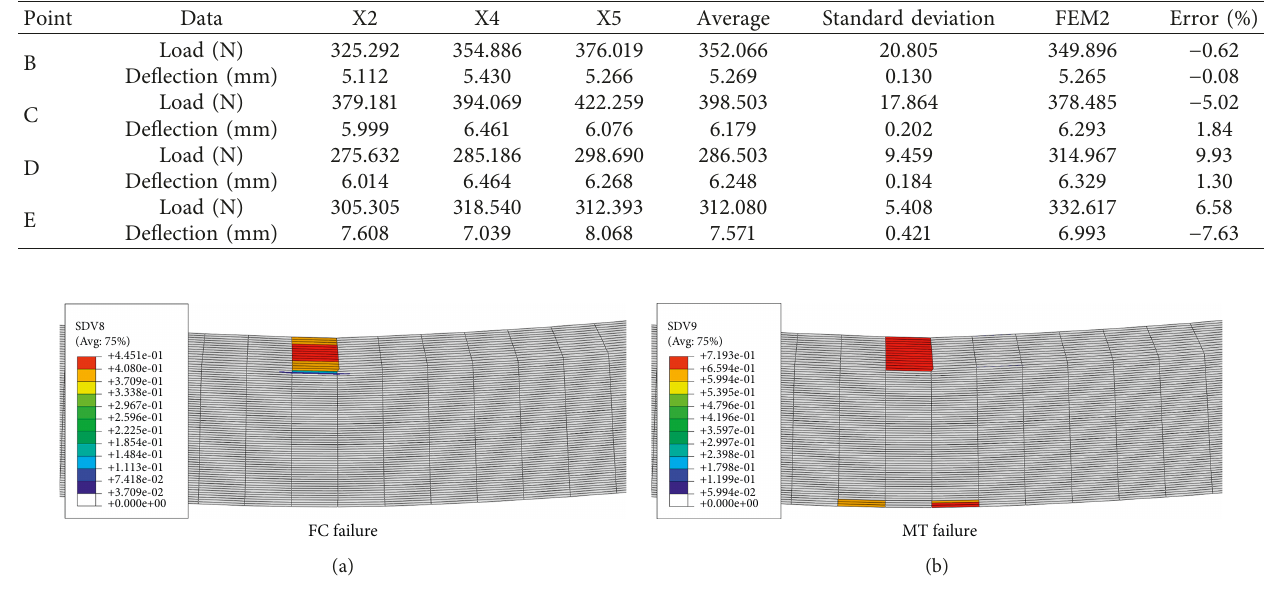
Figure 5: Failure modes at characteristic point A. (a) FC failure and (b) MT failure.